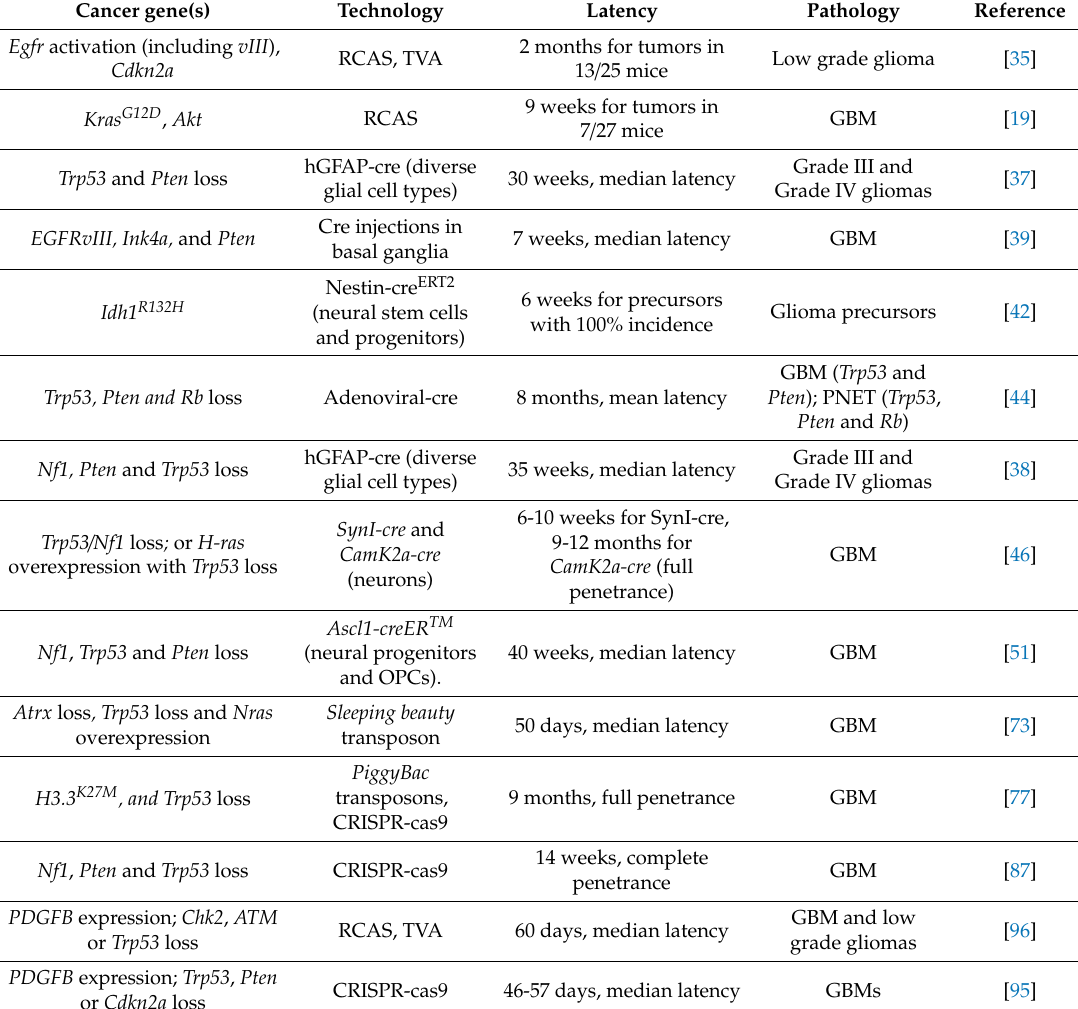
Table 1. A summary of the key published mouse models of